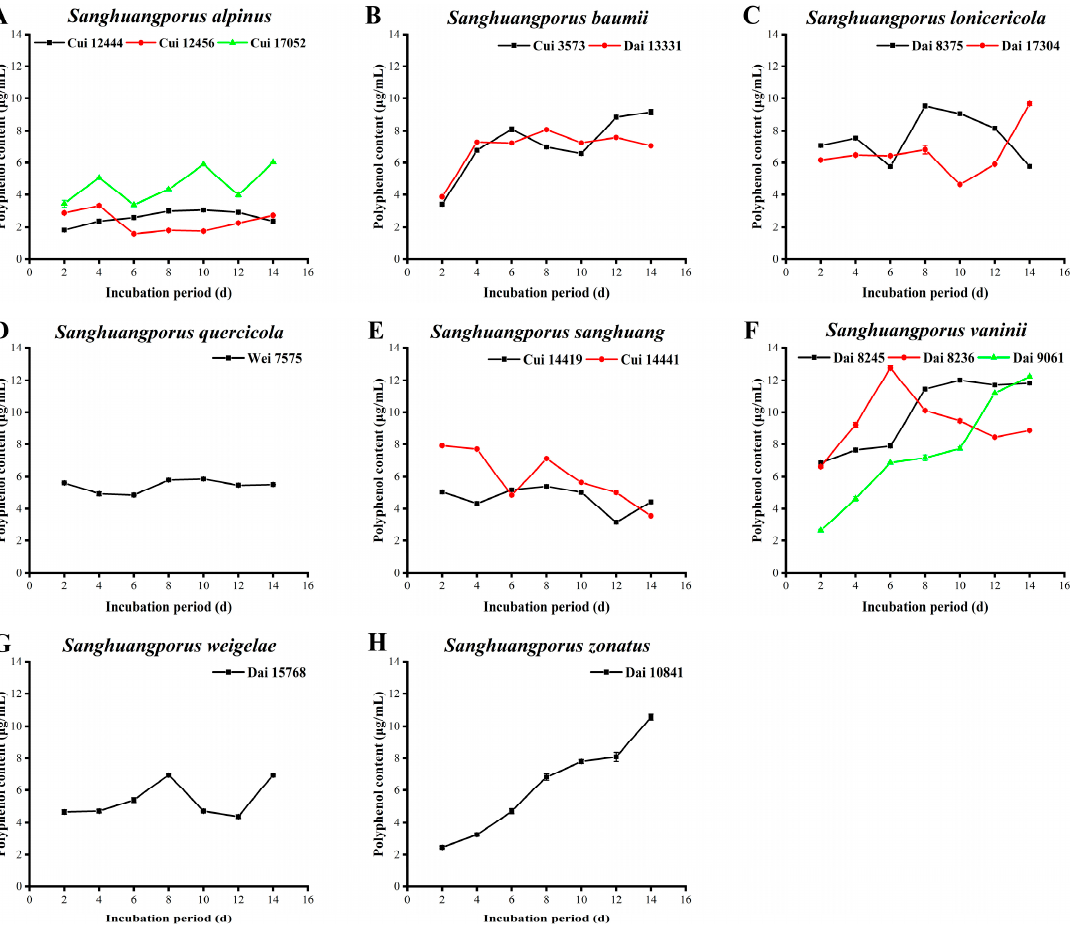
Figure 3. Variations in polyphenol contents during submerged fermentation of 15 wild strains from 8 species of Sanghuangporus . ( A ) Sanghuangporus alpinus Cui 12444, Cui 12456, and Cui 17052. ( B )